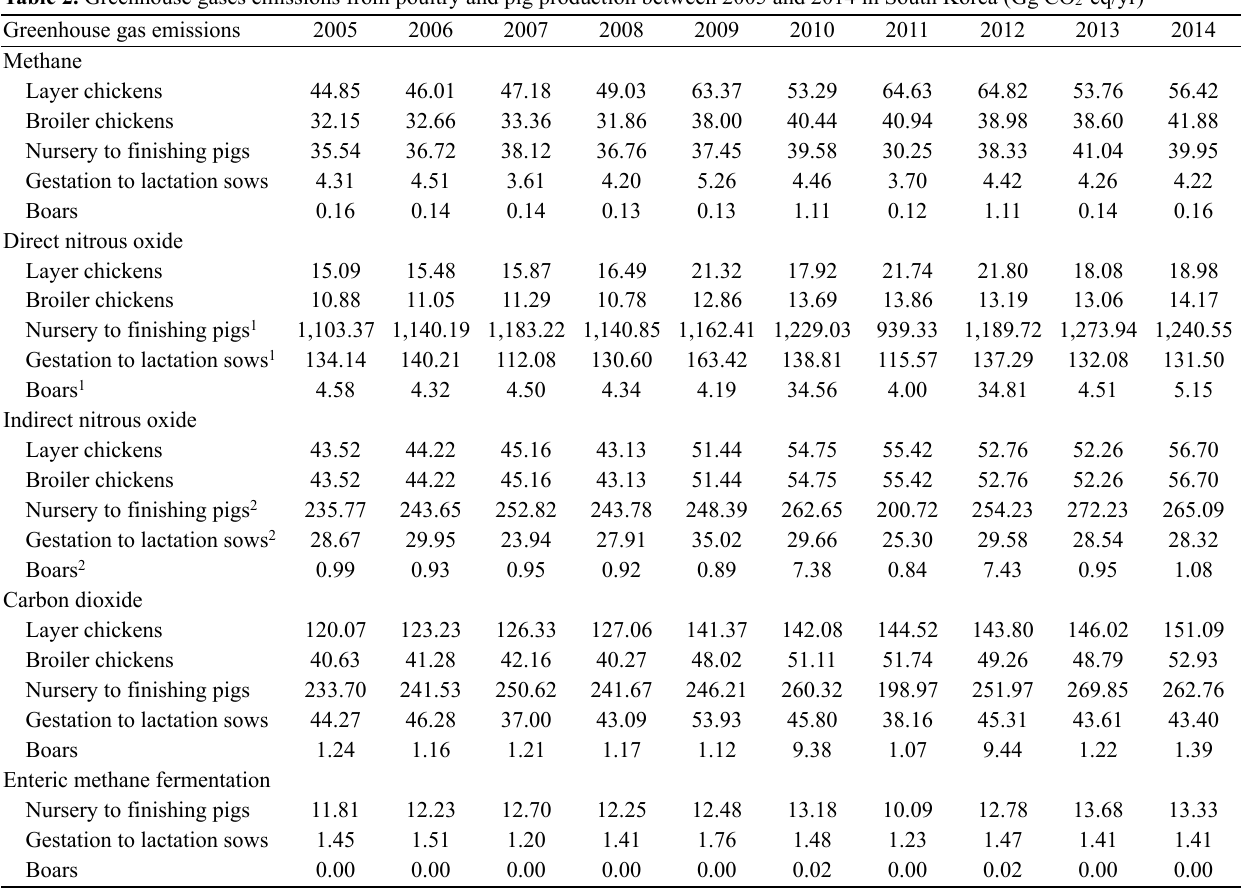
Table 2. Greenhouse gases emissions from poultry and pig production between 2005 and 2014 in South Korea (Gg CO 2 -eq/yr) Greenhouse gas